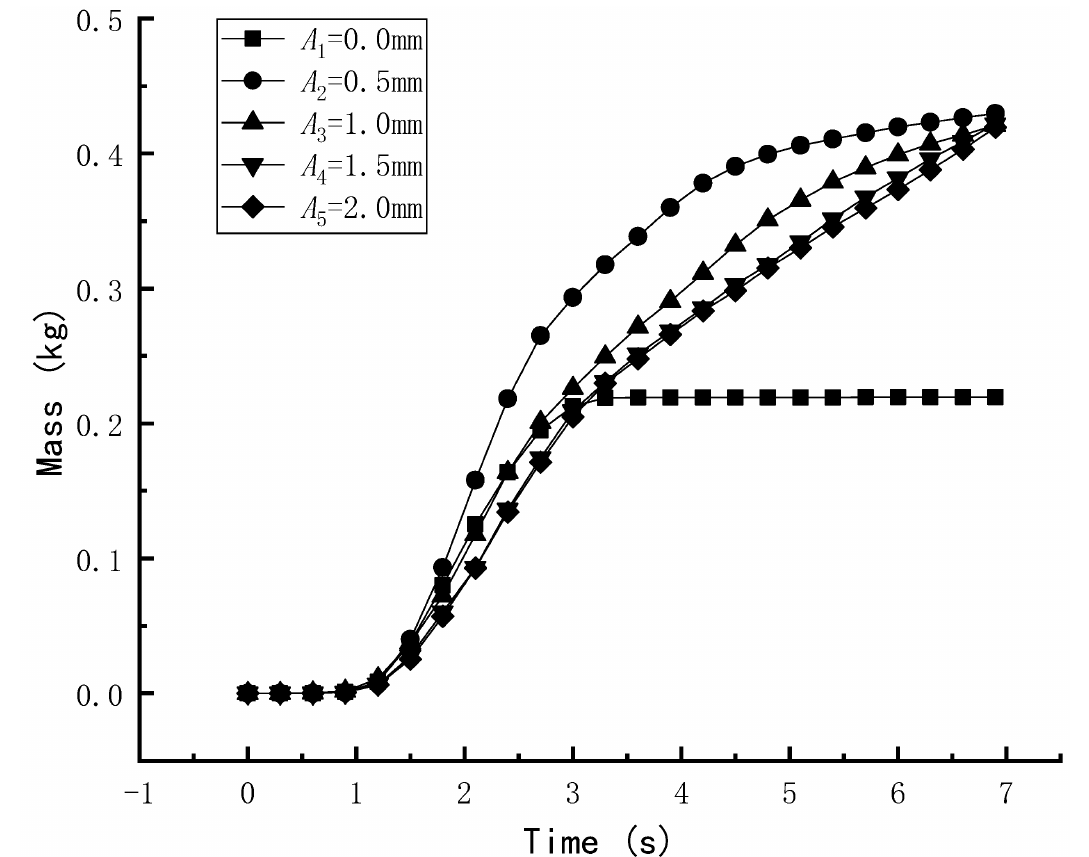
Figure 10. Variation curve of rice-filling mass with different amplitudes.